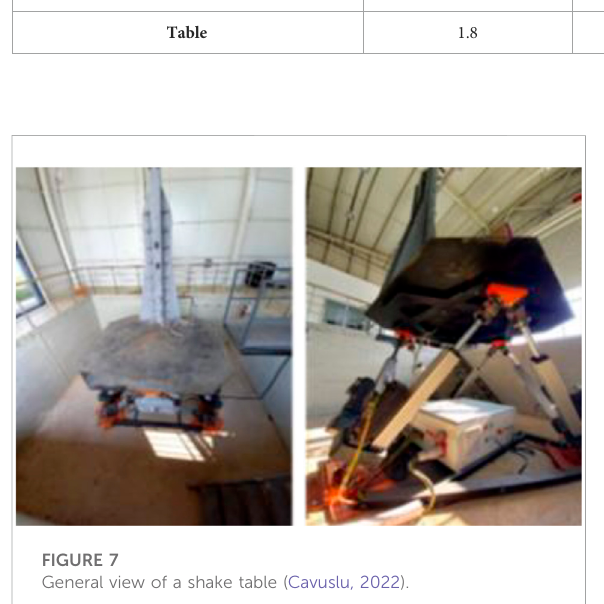
General view of a shake table (Cavuslu,